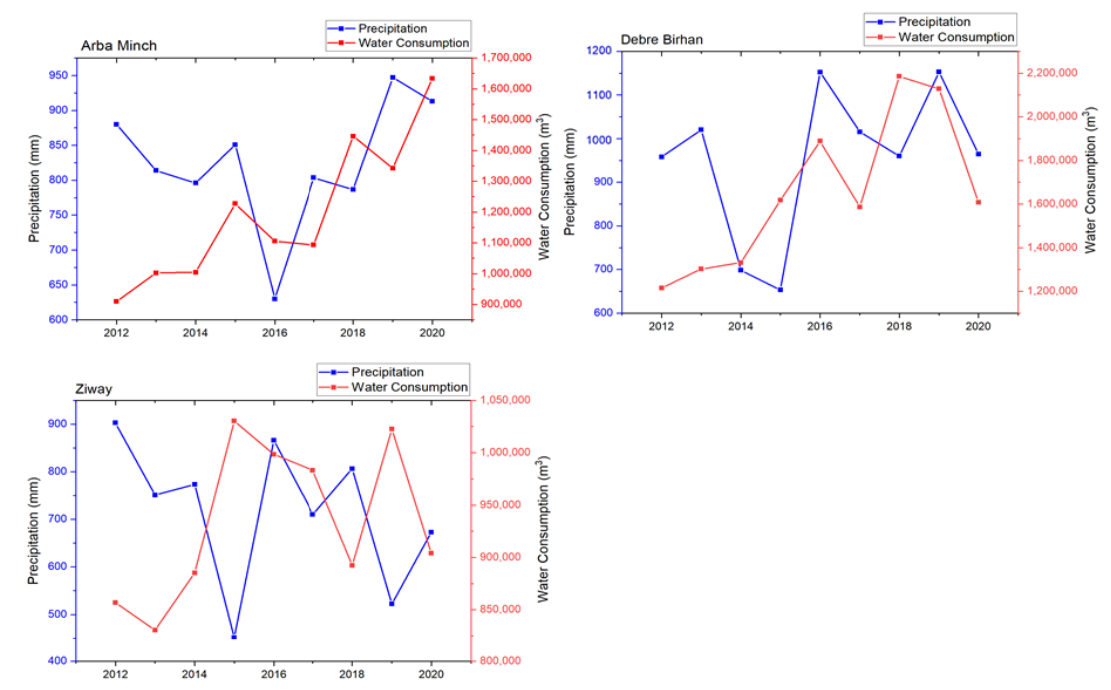
Figure 6. Annual average precipitation vs. average water consumption.